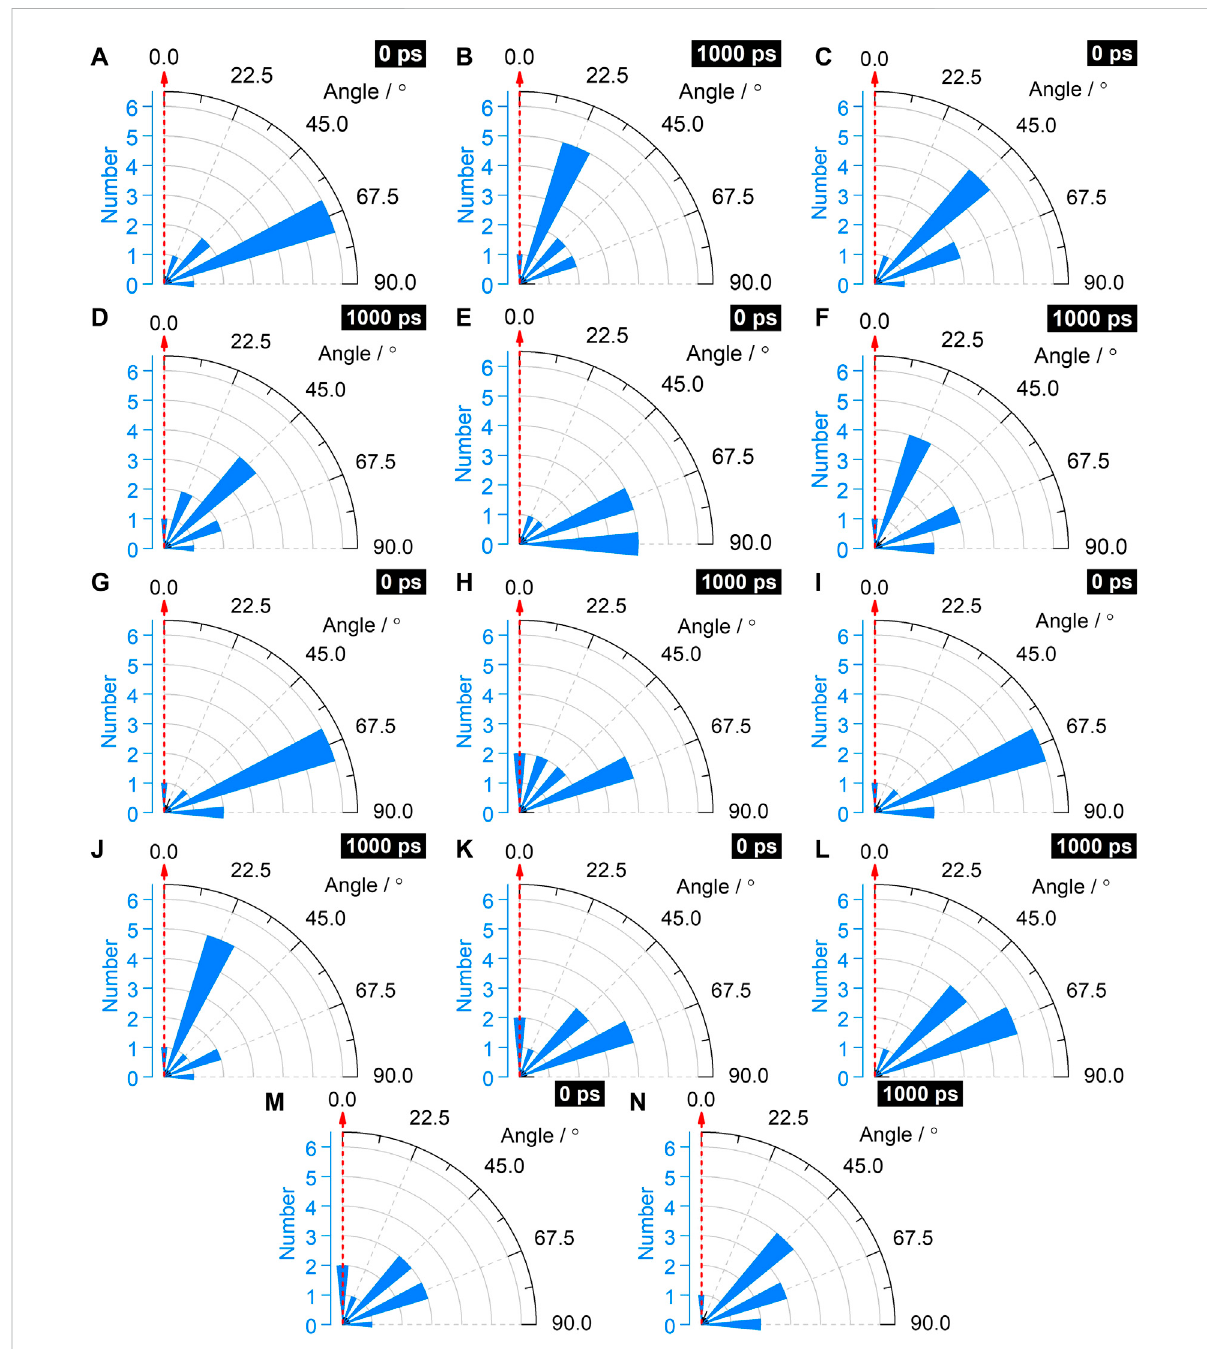
Rosediagramoftheorientation ofthefused aromaticchains. (A) and (B) Pentacene, (C) and (D) phenanthrene, (E) and (F) anthraceneA, (G) and (H) naphthalene A, (I) and (J) naphthacene, (K) and (L) anthracene B, (M) and (N) naphthalene